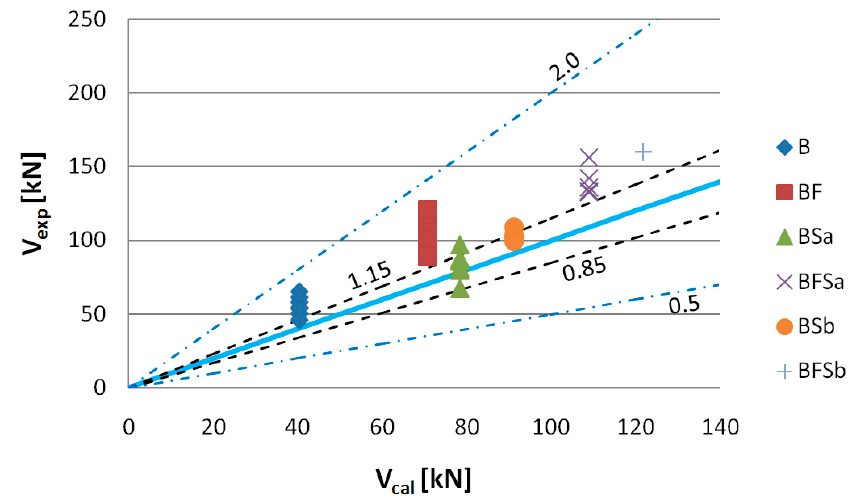
Figure 24. Values of experimentally fixed ( V exp ) versus computational ( V cal ) shear capacity deter- mined according to the RILEM TC-162-TDF method ( θ = 30 ◦ ).